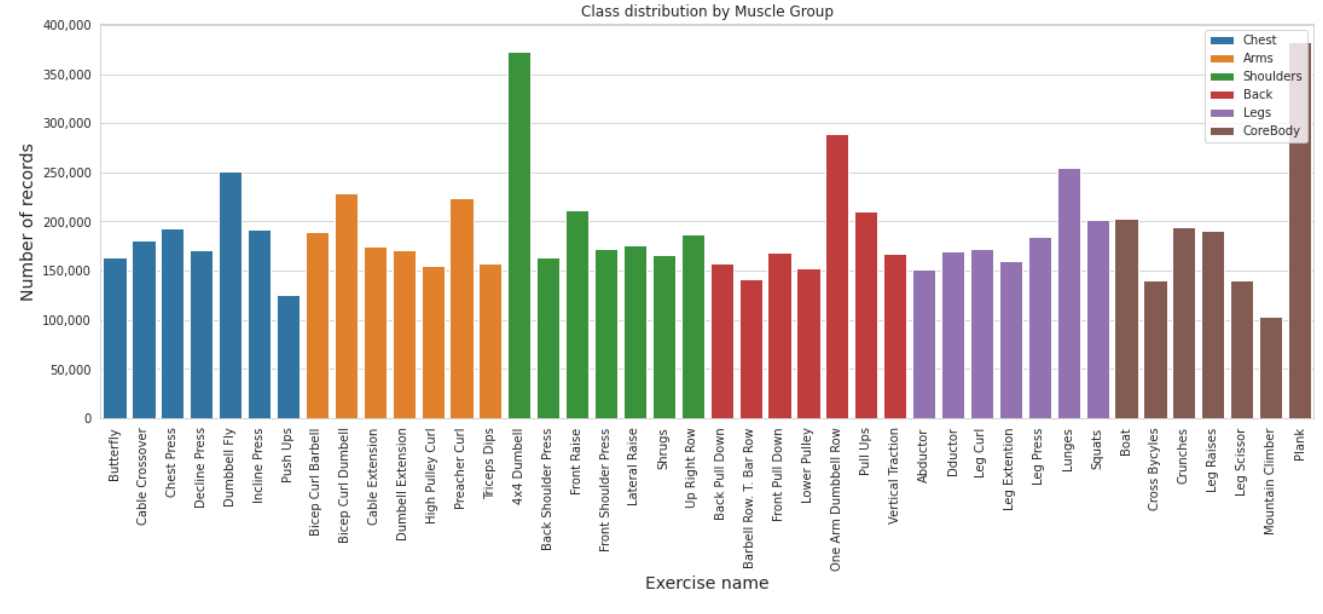
Figure 1. Exercise-wise instance